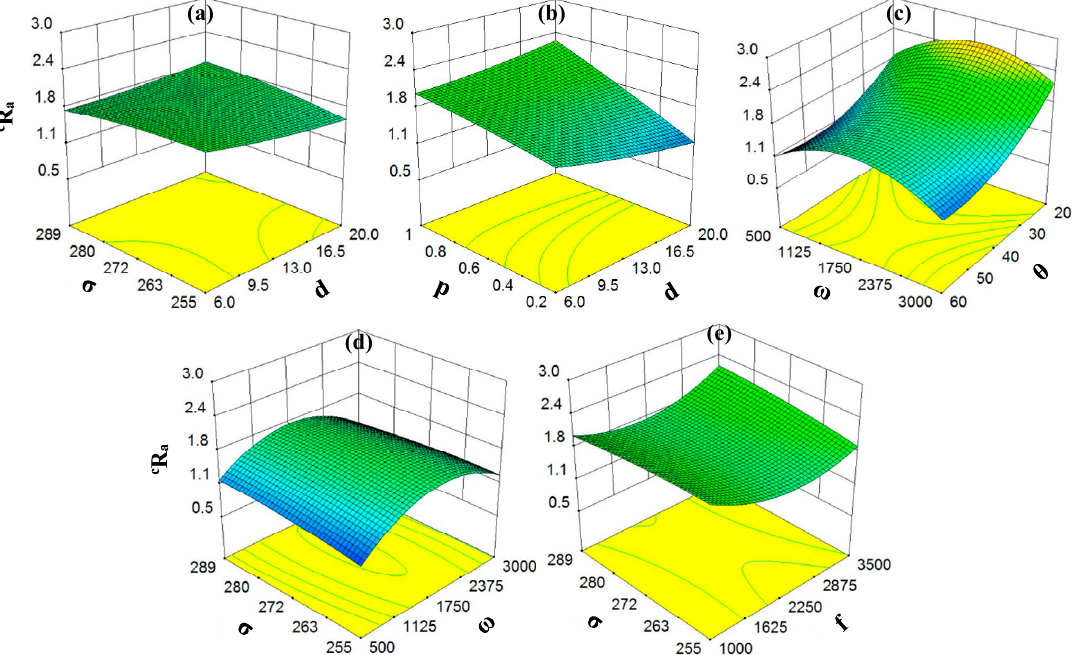
Figure 12. Correlation between the contact-surface roughness and process parameters: ( a ) Combined tool diameter and tensile stress, ( b ) Combined step size and tool diameter, ( c ) Combined tool rotation and forming angle, ( d ) Combined tensile stress and spindle rotation, and ( e ) Combined feed rate and tensile stress.